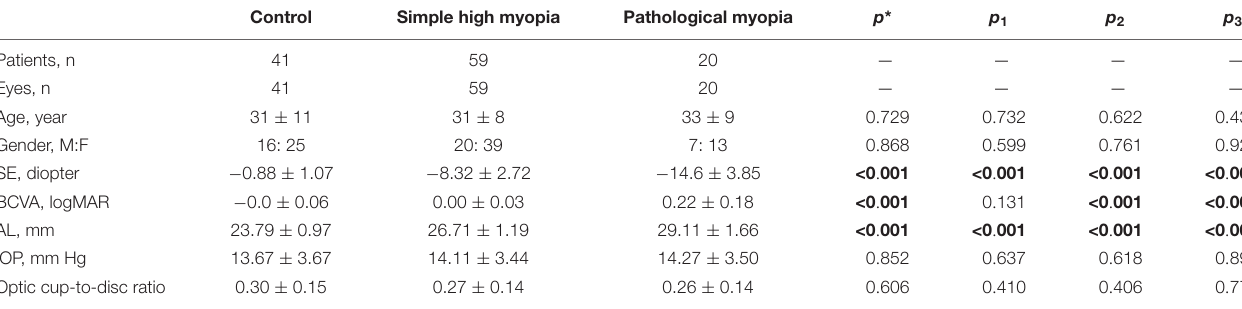
TABLE 1 | The basic characteristic information of the control group, simple high myopia, and pathological myopia.